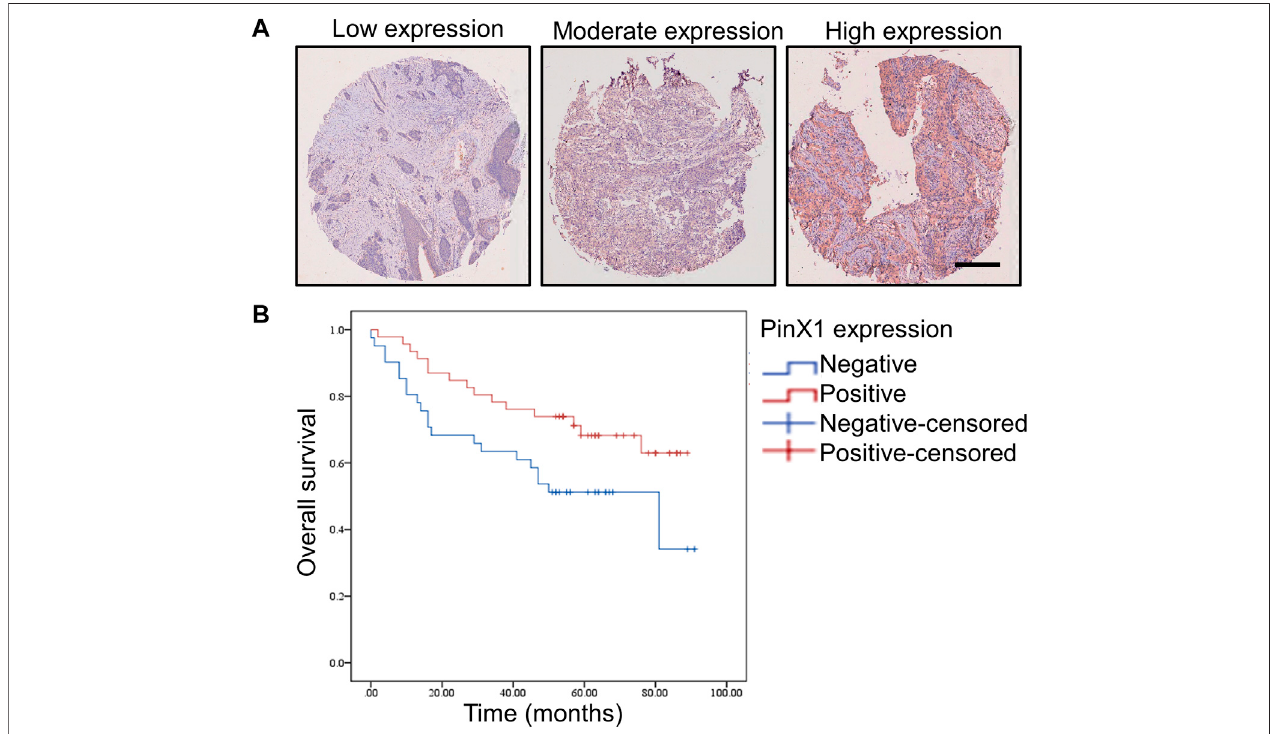
FIGURE 1 | PinX1 expression and the in fl uence on overall survival in human SCC. (A) PinX1 expression in human SCC. Scale bar = 200 μ M. (B) Negative pinX1 expression was correlated with poor overall survival.